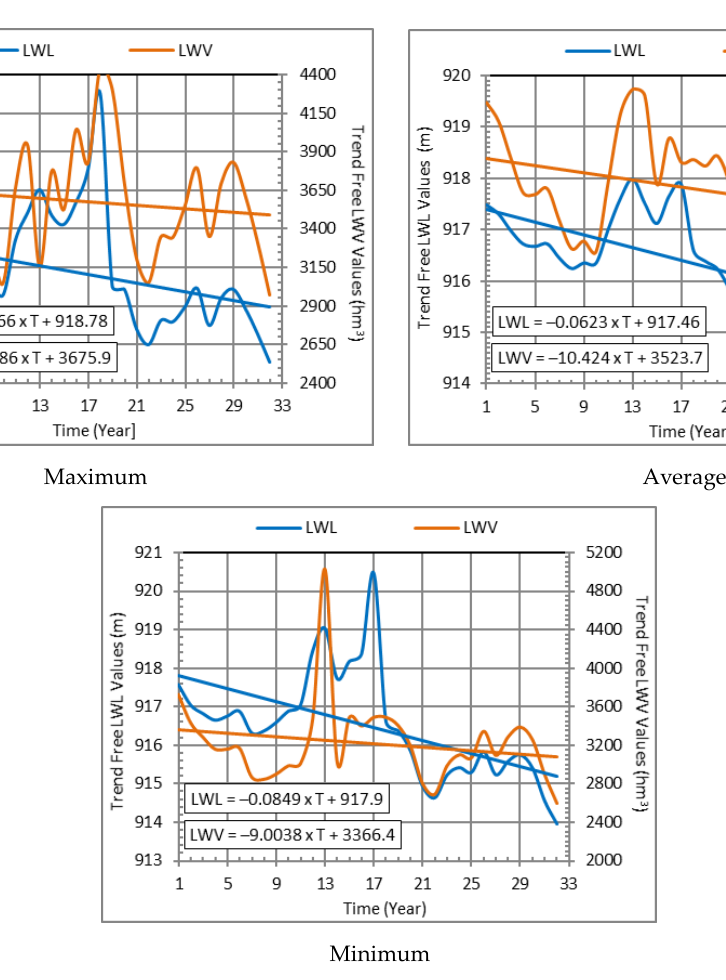
Figure 5. Regenerated annual LWL and LWV series for Lake